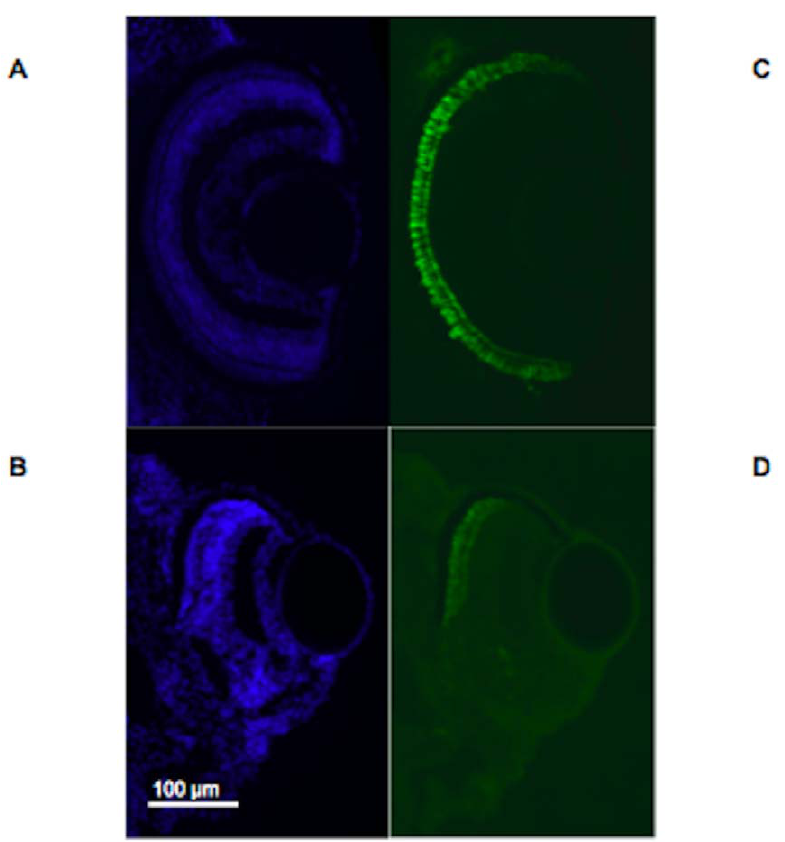
Figure 9. Morphant larvae show altered formation of the ventral eye. Fig. 9A–D. Fig. 9A–B. Staining of control injected zebrafish eye with DAPI and FITC at 6 dpf to image zpr-1 shows a strong signal that can be seen at the ciliary margins of the retina. Fig. 9C–D. Staining of anti-ATG morphant (MO1) zebrafish eye with DAPI and FITC at 6 dpf to image zpr-1 shows absent signal for zpr-1 at the ventral region of the retina in an eye with a coloboma, whereas staining at the dorsal region of the retina appears normal. Fish are oriented so that the ventral surface of the eye is seen inferiorly in each photograph.